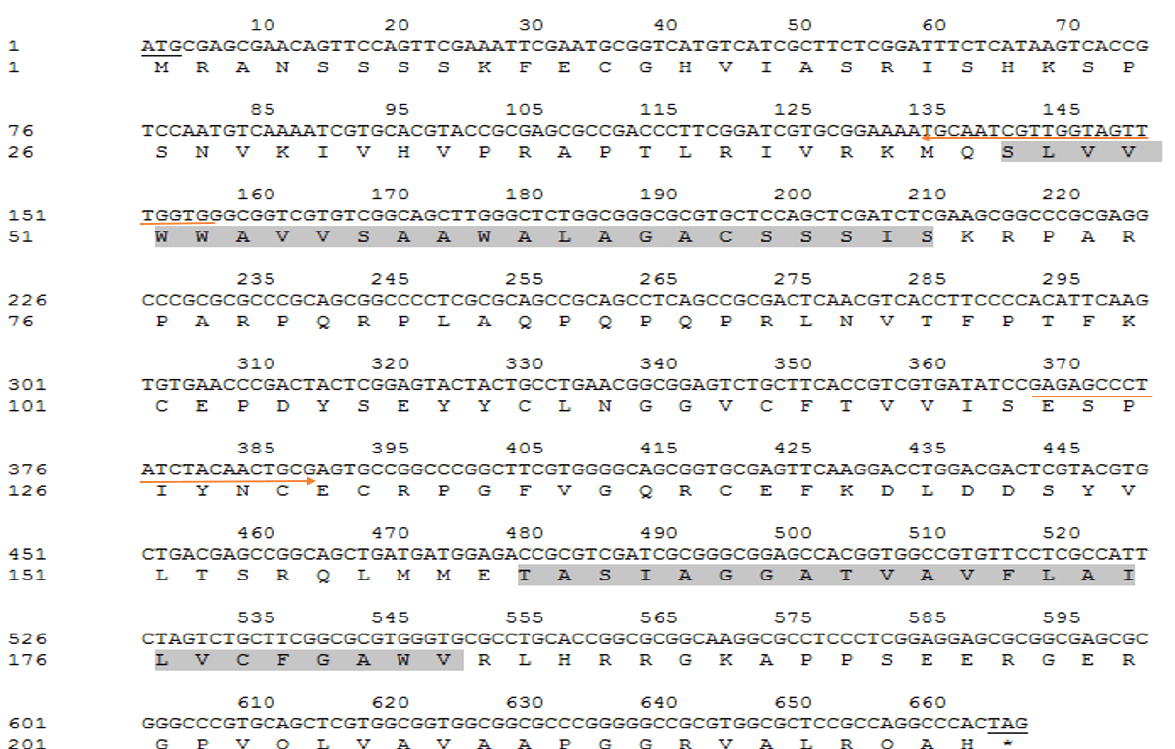
Figure 1. Nucleotide sequence and deduced amino acids of ApEGF . The underlined sequence indicates the start codon and stop codon, and light gray indicates the two transmembrane domains. The red arrow pointing to the right ( → ) indicates the forward primer sequence and pointing to the left ( ← ) indicates the reverse primer